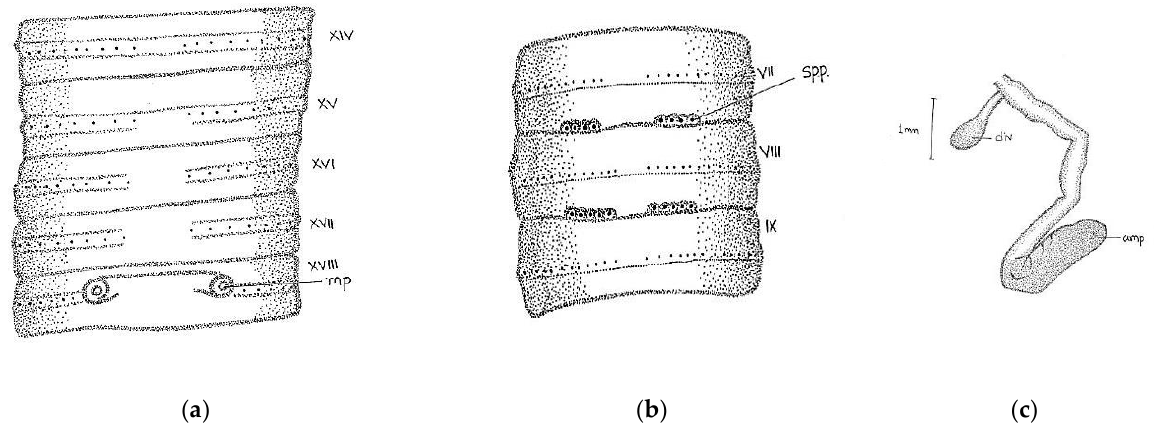
Figure 7. Camera lucida illustration of Megascolex polytheca zonatus ( a ) genital region; ( b ) spermathecal pore; ( c ) spermathecae.